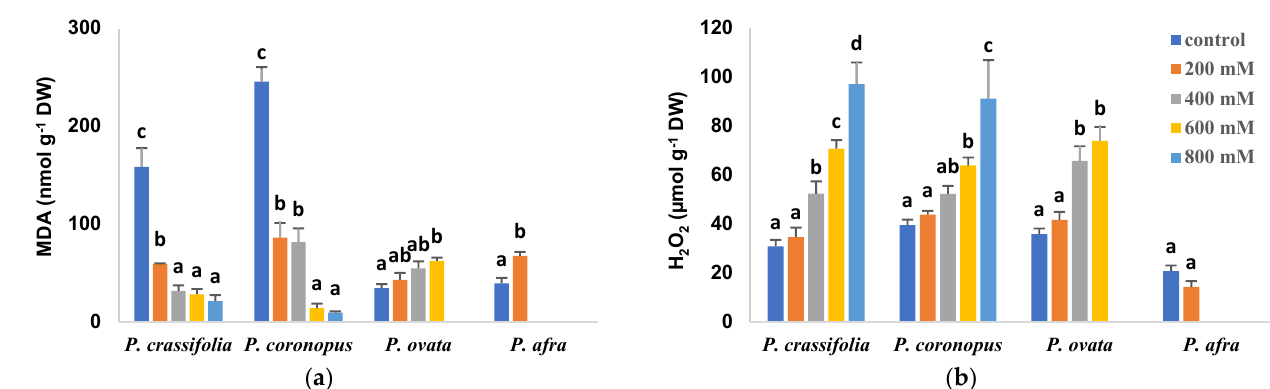
Figure 7. Leaf contents of malondialdehyde (MDA) ( a ) and hydrogen peroxide (H 2 O 2 ) ( b ) in the four selected Plantago species, after four weeks of treatment with the indicated NaCl concentrations. The values shown are means ± SE ( n = 5). For each species, different letters over the bars indicate significant differences between treatments, according to the Tukey test ( p < 0.5).